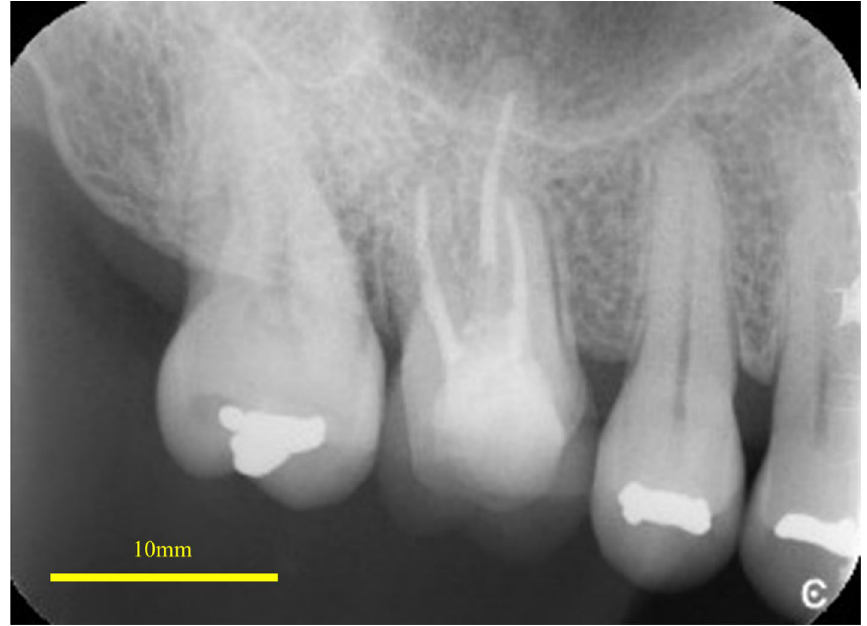
Figure 4. Digital X-ray image of PEEK crowns placed intraorally PEEK crown on the non-vital tooth with resin abutment and can be seen in the thin opaque image.